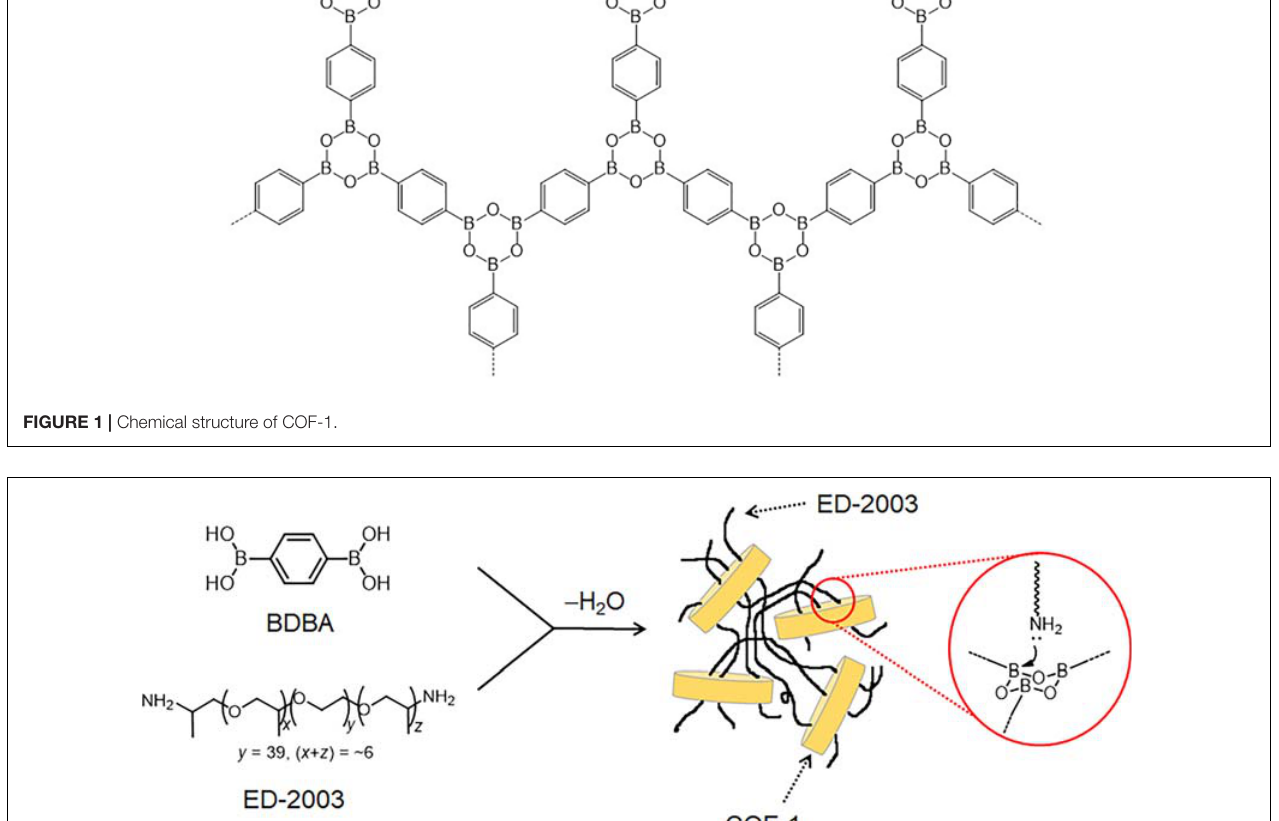
of Li + and ether oxygen of ED-2003 is denoted as Li/O, and their values are 0.04, 0.08, 0.13, 0.14, 0.17, and 0.20, respectively. After mixing, SME/LiTFSA composites were dried in vacuo at 60 ◦ C for 24 h prior to